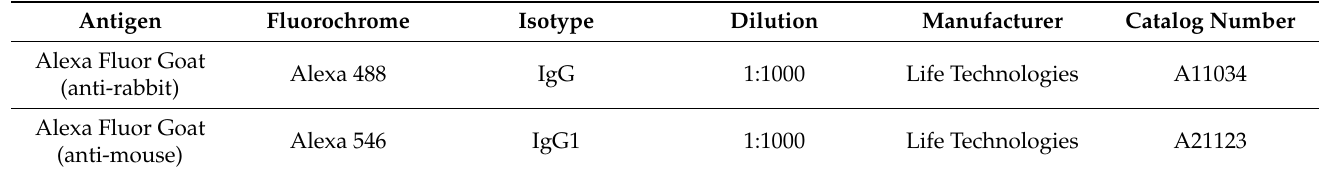
Table 2. Secondary antibodies used for immunocytochemical